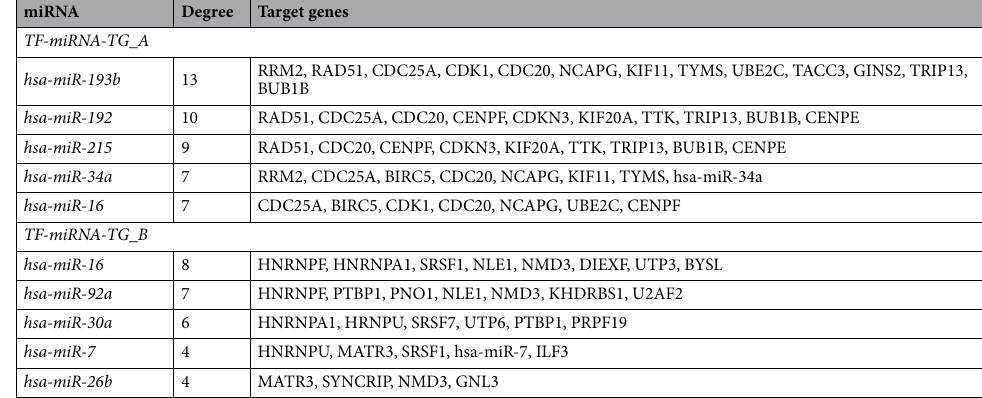
Table 3. High degree nodes of the miRNAs in the TF-miRNA-TG_A and B sub-networks.